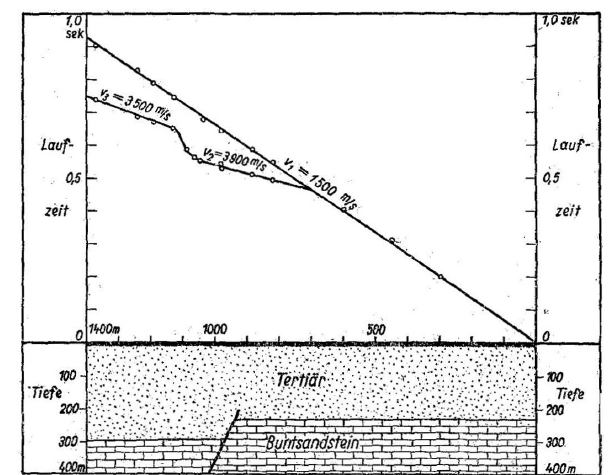
Figure 5. Travel time curves of the longitudinal waves, recorded above a geologically hidden fault zone. Below the tertiary surface a faulted region of red sandstone causes the two kinks in the travel time curve (from Mintrop,